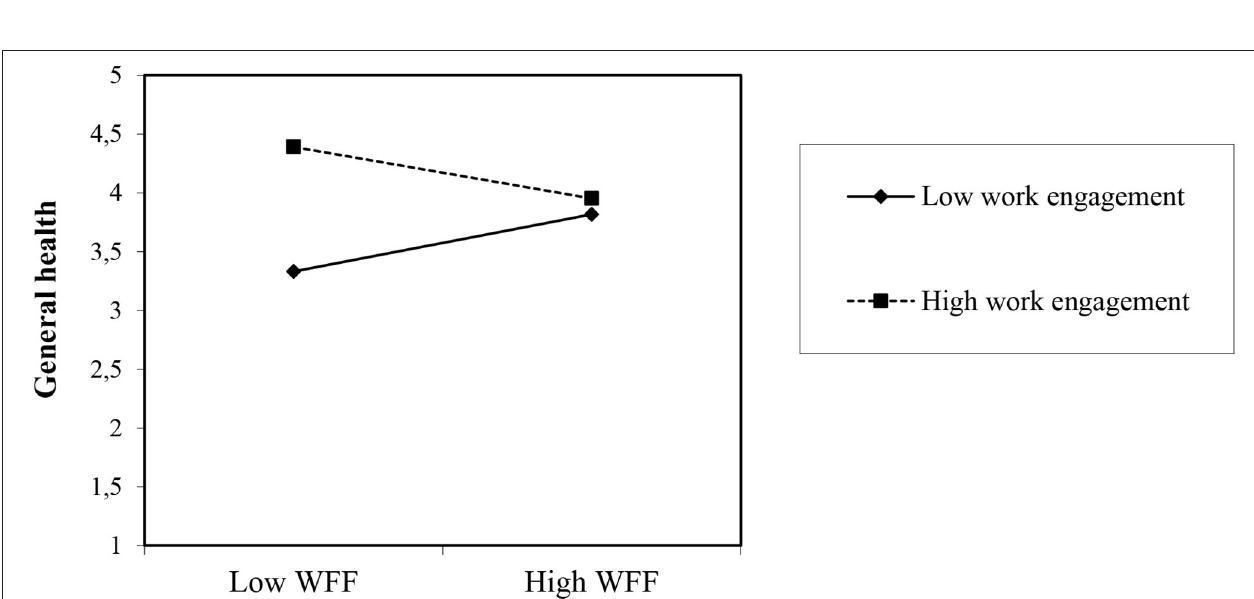
FIGURE 4 | Interaction effects of daily work engagement and day-level of WFF in predicting general health at night. WFF, Work-Family Facilitation.